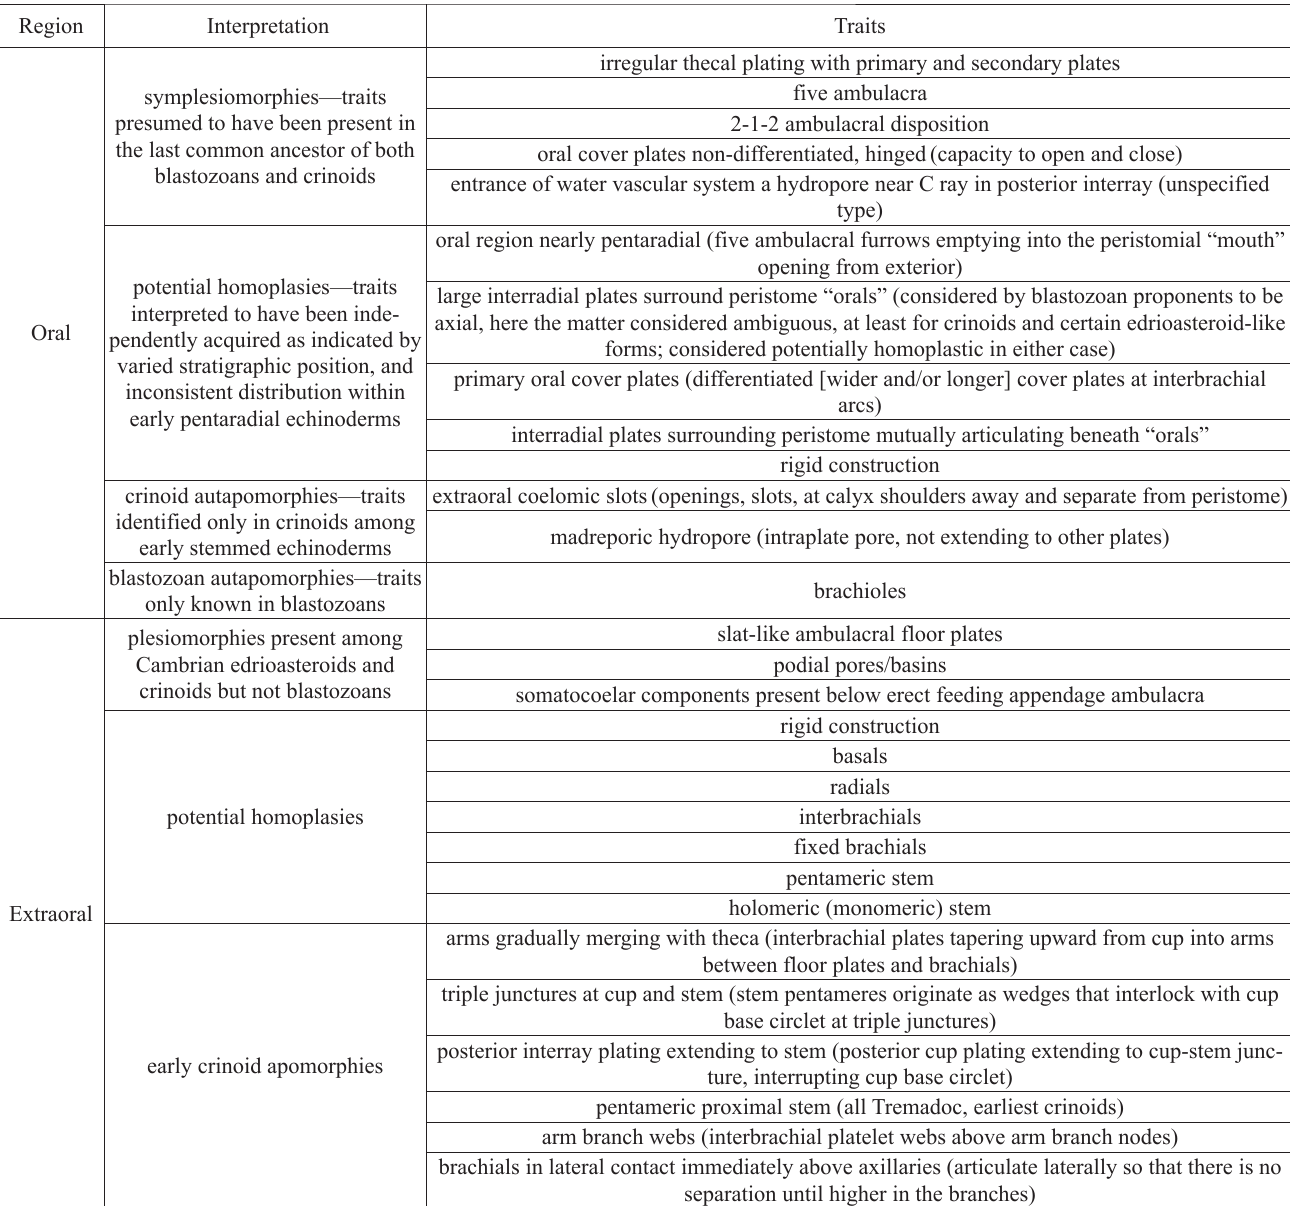
Table 1. Phylogenetic interpretation of Ordovician blastozoan and crinoid morphology.